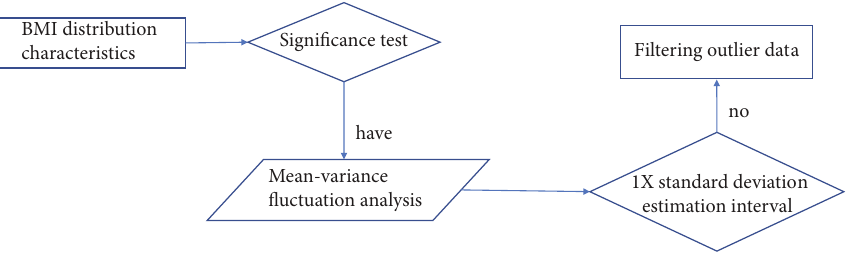
Figure 3: Back generation model of the e ff ect of BMI on physical